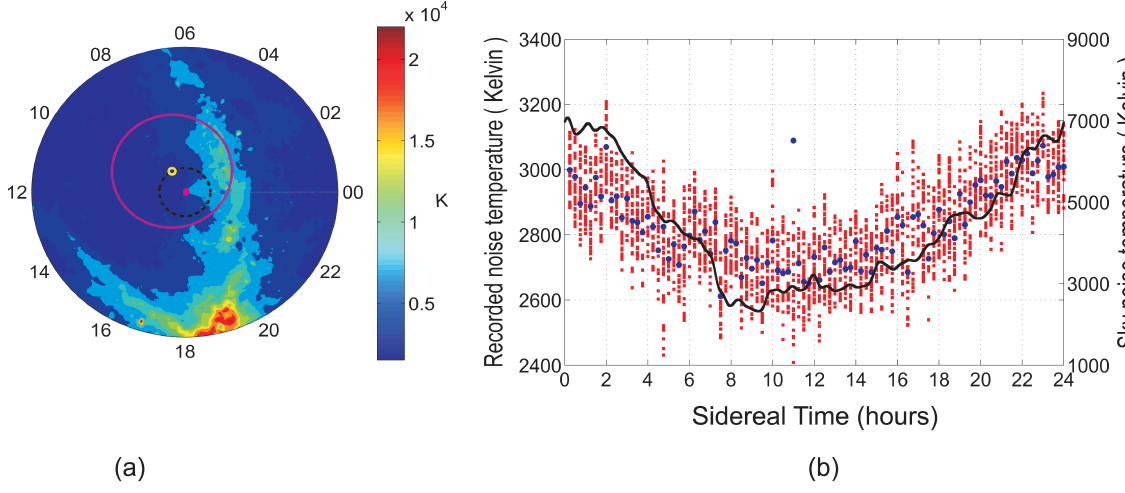
Fig. 2. (a) The sky noise at 51.5MHz for the entire Northern Hemisphere. The red dot at the center refers to the geographic north pole. The black dash-dash line in figure shows the path of the centroids of the Main-Mode vertical and Quartet beams across the celestial sphere in a sidereal day. While the Main beam covers a small cross-sectional area (yellow circle), the Quartet beam covers a larger cross-sectional area (magenta circle). See text for detail. (b) A comparison of 15min averaged recorded sky noise (red dots) with the sky survey map values (black line) in the case of Main-Mode vertical beam. A total of 11 days in August 2001 were selected for the comparison, and the blue dots refer to the mean values in each time